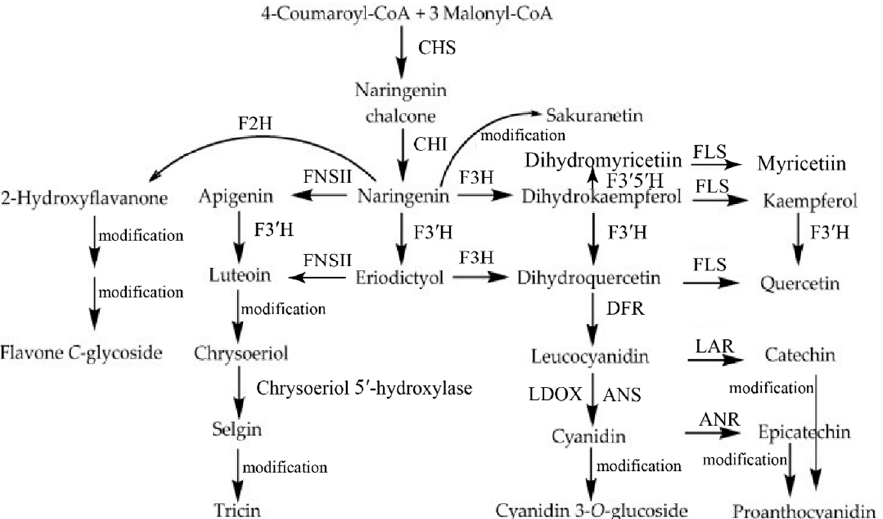
Figure 1. Proposed flavonoid biosynthetic pathway in rice [43,57,66]. Arrows represent enzymatic steps: CHS, chalcone synthase; CHI, chalcone isomerase; F3H, flavanone 3-hydroxylase; F2H, fla-